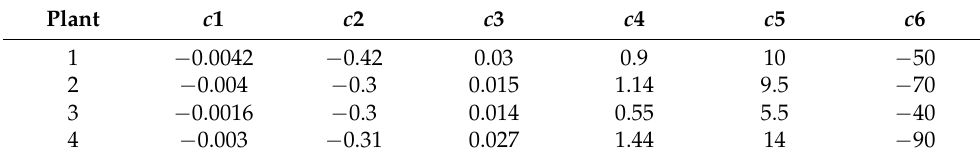
Table 7. Output coefficient hydropower stations.